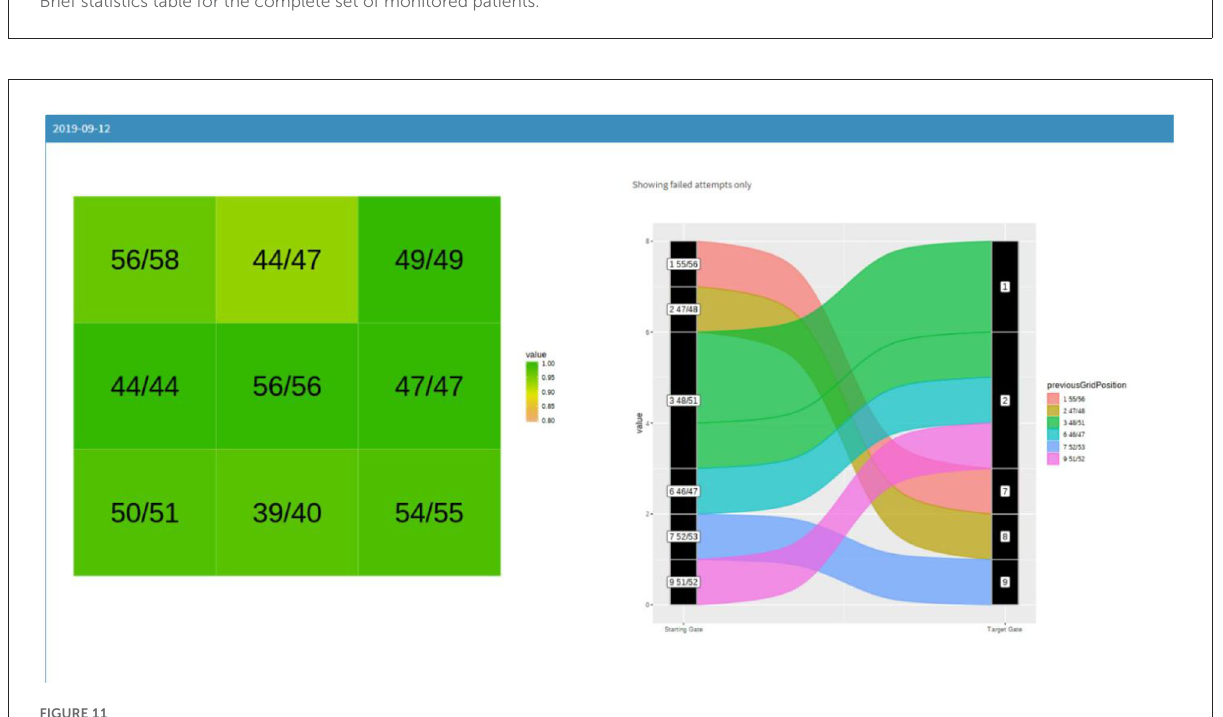
FIGURE11 Success rate per gate and Sankey diagram.